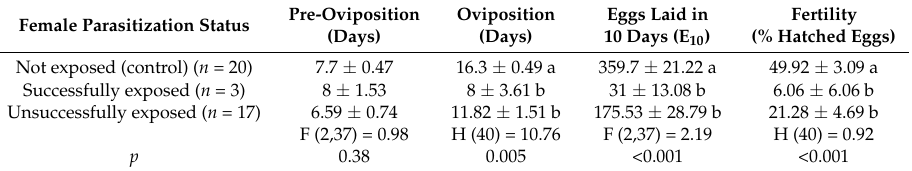
Table 4. Pre-oviposition and oviposition duration in days, total eggs laid in 10 days (E 10 ), fertility (% hatched eggs) (means ± SE) of H. axyridis females not exposed to D. coccinellae (control), exposed and successfully parasitized (successfully exposed), or exposed but not successfully parasitized (unsuccessfully exposed). All females were paired with not exposed males. Pre-Oviposition Female Parasitization Status (Days) Not exposed (control) ( n =